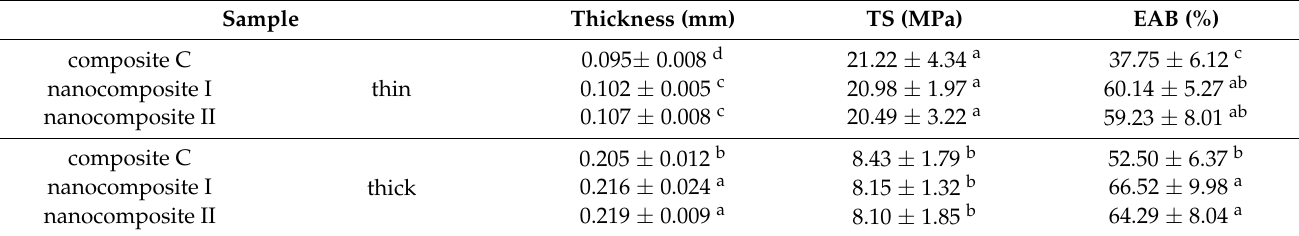
Table 6. Water content, solubility, and degree of swelling of composites